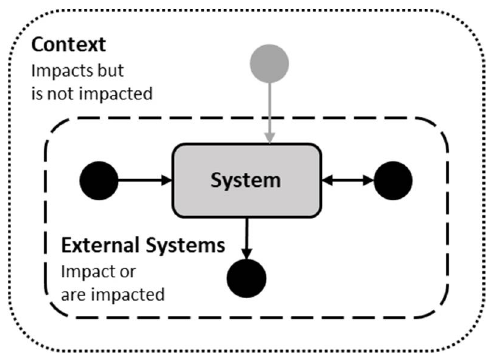
Figure 3. System, External Systems and Context (adapted from [25]).